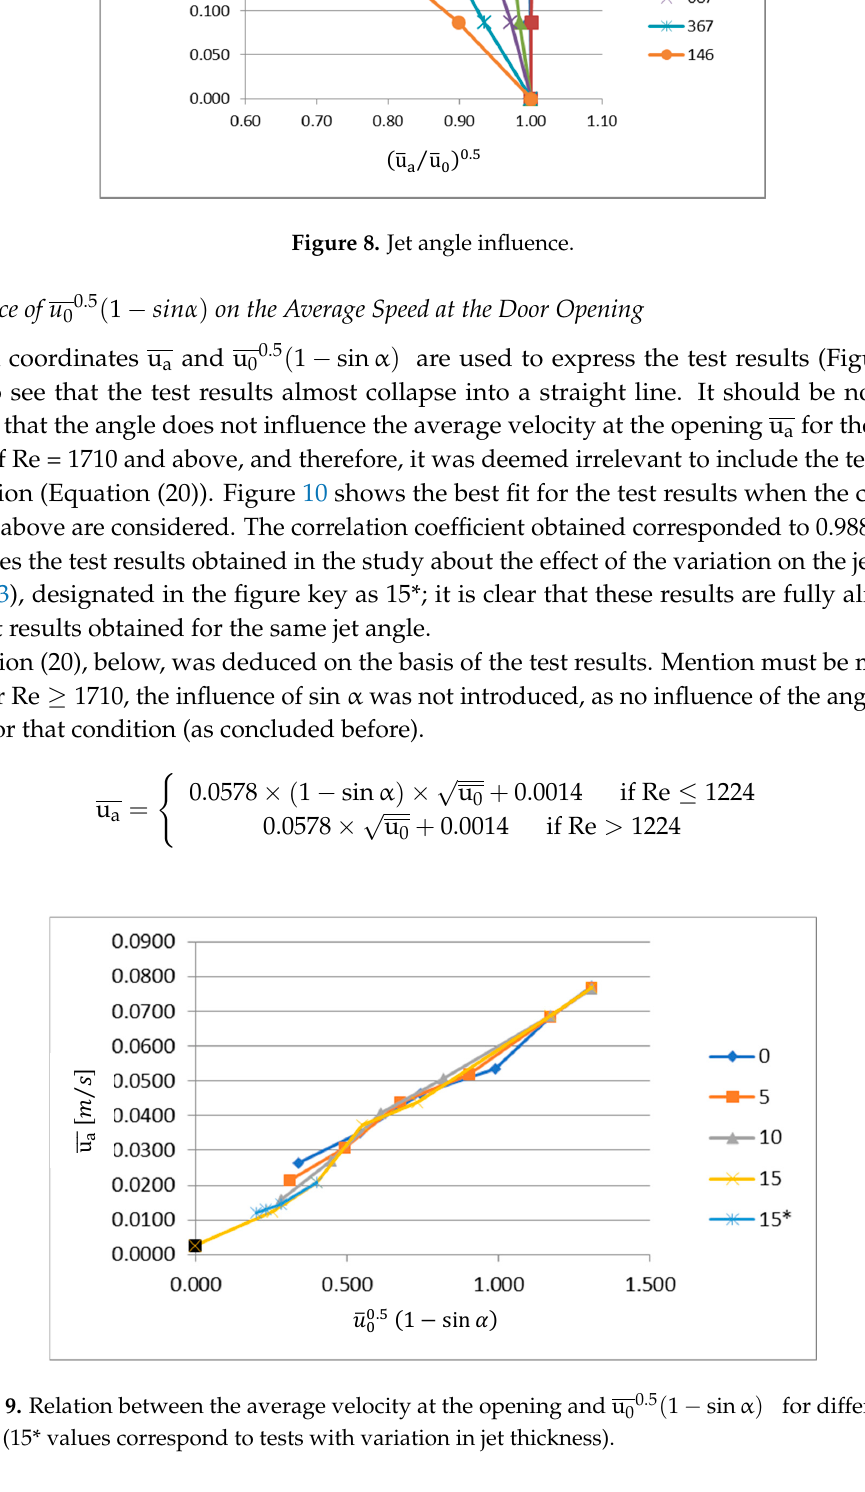
Figure 9. Relation between the average velocity at the opening and u 00.5 ( 1 − sin α ) for different jet angles (15* values correspond to tests with variation in jet thickness).